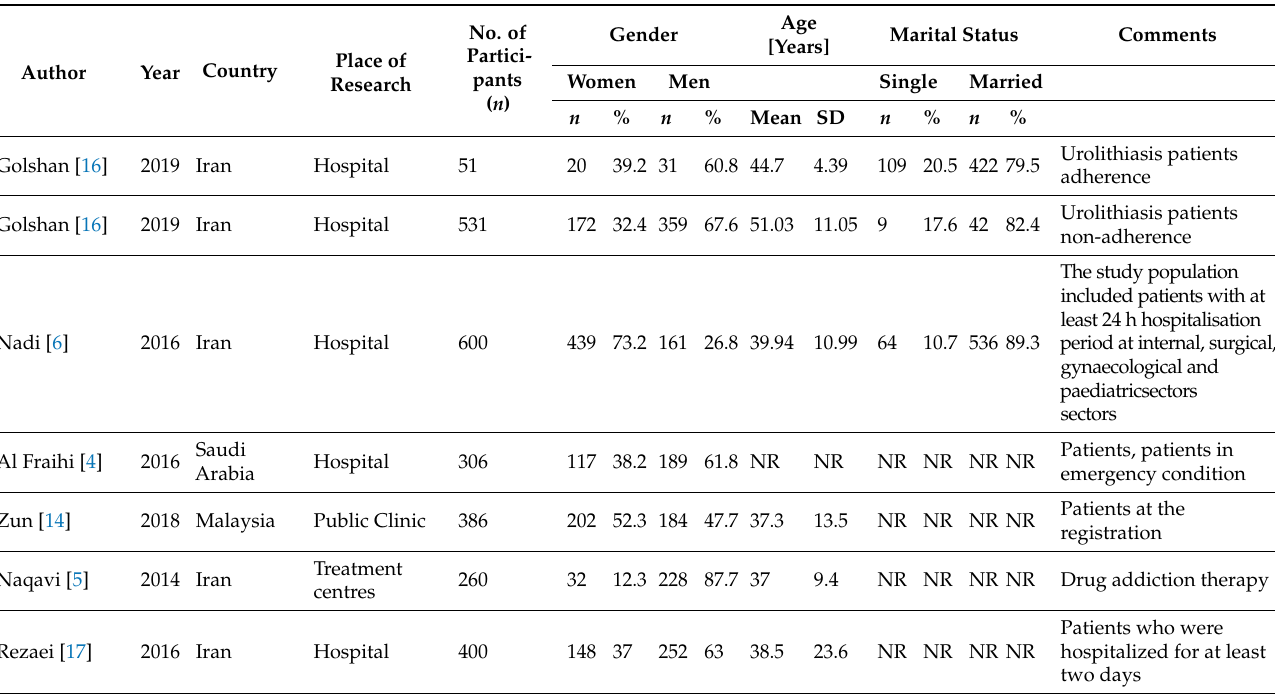
Table 1. Characteristics of the studies, included in this meta-analysis.